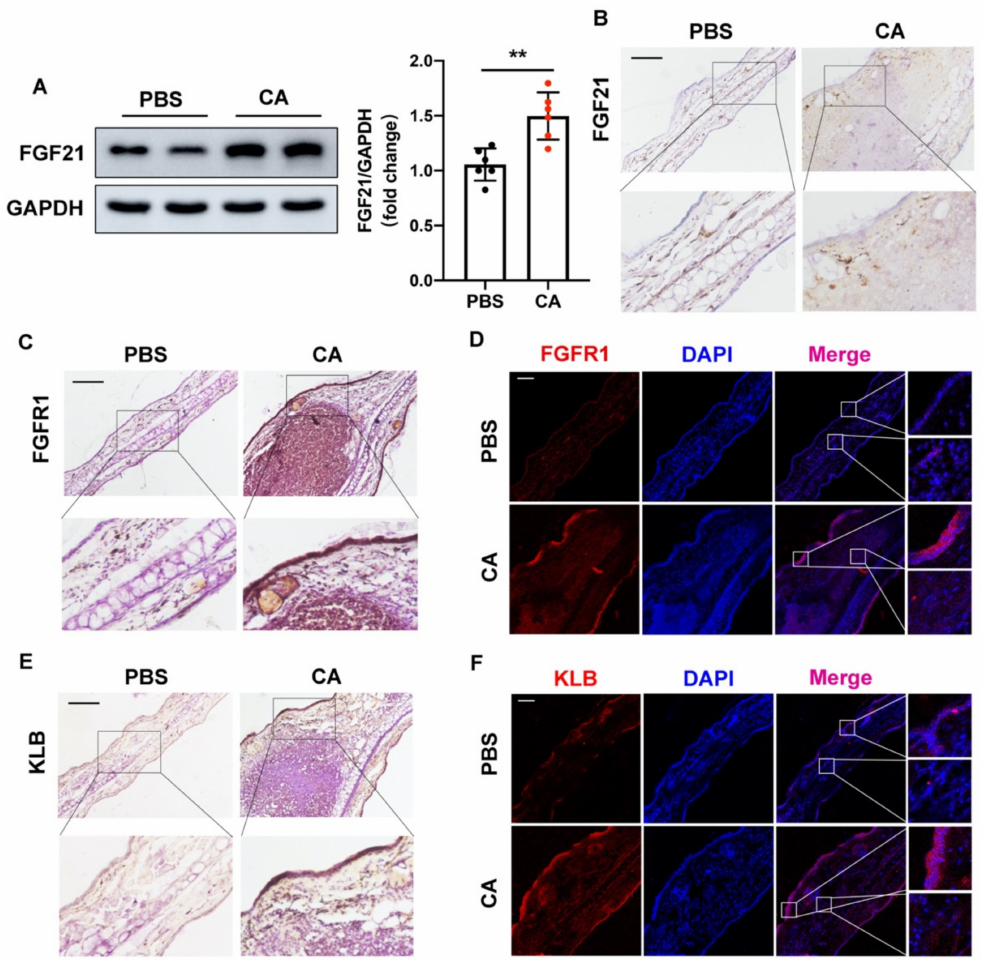
Figure 1. Upregulation of FGF21 in C. acnes -stimulated skin. ( A ) Protein expression and quantitative analysis of FGF21 in mouse ears treated with phosphate buffered saline (PBS) or 2 × 10 7 CFU/mL living C. acnes (CA) for 24 h ( n = 5 mice/group). ( B , C , E ) Representative IHC staining of FGF21, FGFR1, and KLB in ears of PBS and C. acnes -induced mice ( n = 5 mice/group; magnification × 100). Scale bar = 100 µ m. ( D , F ) Representative confocal scans are shown for FGFR1 and KLB (red), and the nuclei are stained with DAPI (blue) ( n = 5 mice/group). The pictures in the upper-right corner and the lower-right corner are enlarged views of the epidermis and the dermis in the box areas, respectively. Scale bar = 100 µ m. All data are presented as the mean ± the SD; ** p <